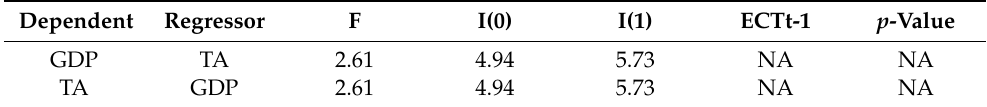
Table 3. Preliminary ARDL bounds test result.